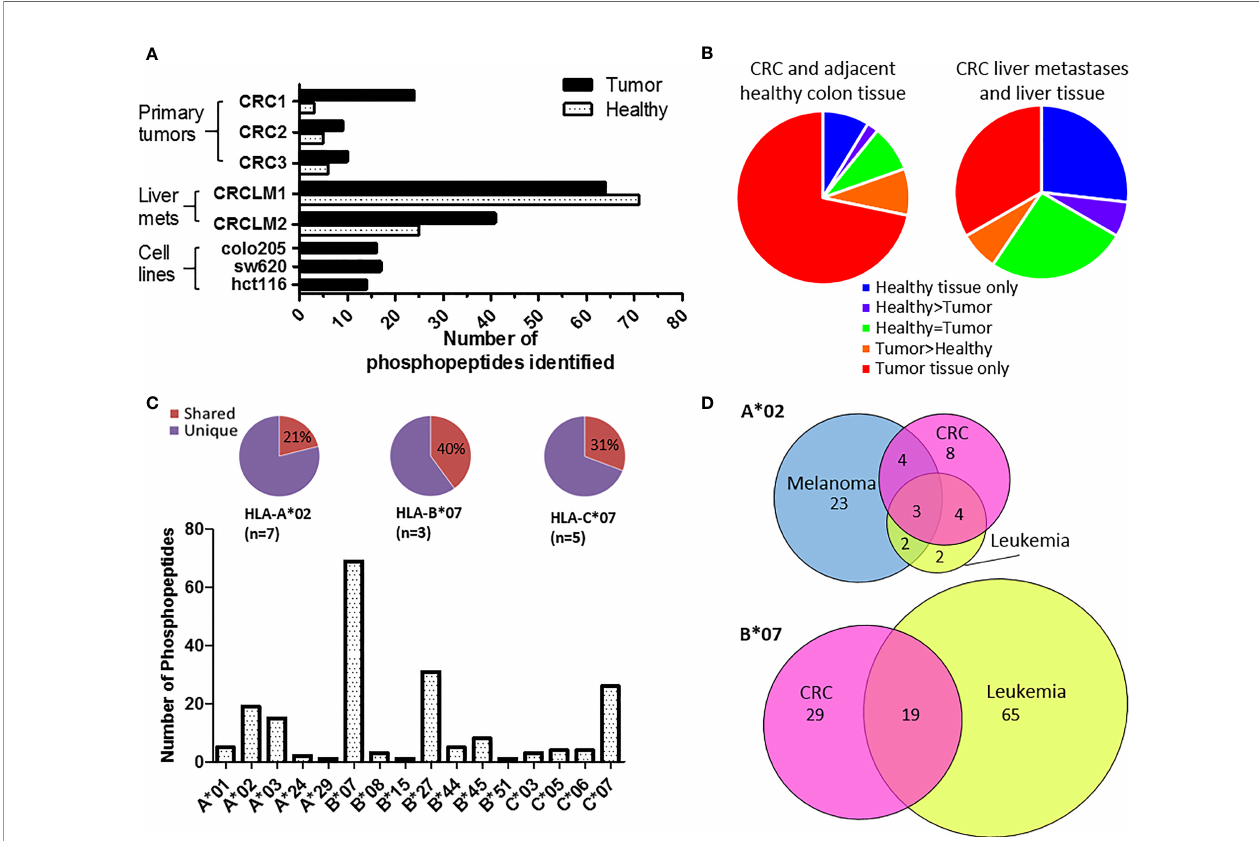
FIGURE 2 | Phosphopeptides identi fi ed from colorectal cancer samples – putative cancer antigens. (A) Comparison of phosphopeptides identi fi ed on tumors and healthy tissue from CRC patients with primary (n=3) and secondary (n=2) tumors and CRC cell lines (n=3). (B) Proportion of the phosphopeptides identi fi ed on primary and secondary tumors that were healthy speci fi c (not detected on tumor) (blue), healthy associated (more detected on healthy than tumor tissue) (purple), equal (where equal was within one order of magnitude) (green), tumor associated (more detected on tumor than healthy tissue) (orange) and tumor speci fi c (not detected on healthy tissue) (red). (C) The number of phosphopeptides identi fi ed predicted to bind to different HLA-I. Pie charts show the proportion of phosphopeptides shared (red) across multiple patients ’ samples for the most common HLA-alleles. (D) Overlap of HLA-A*02 and HLA-B*07 phosphopeptides identi fi ed on CRC (pink) with those found on other types of malignancy; melanoma (blue) and leukemia